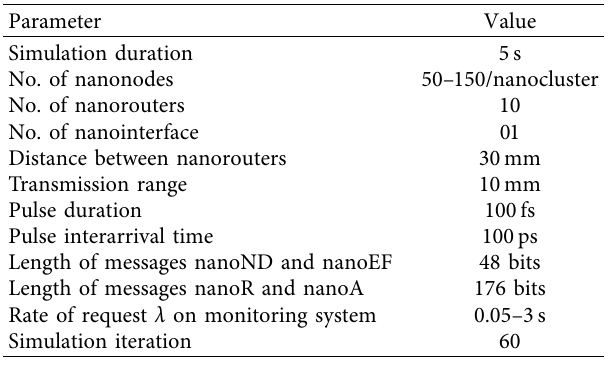
Figure 18: Nearest nanorouter and nanointerface both are not in the transmission range. Table 4: Parameter